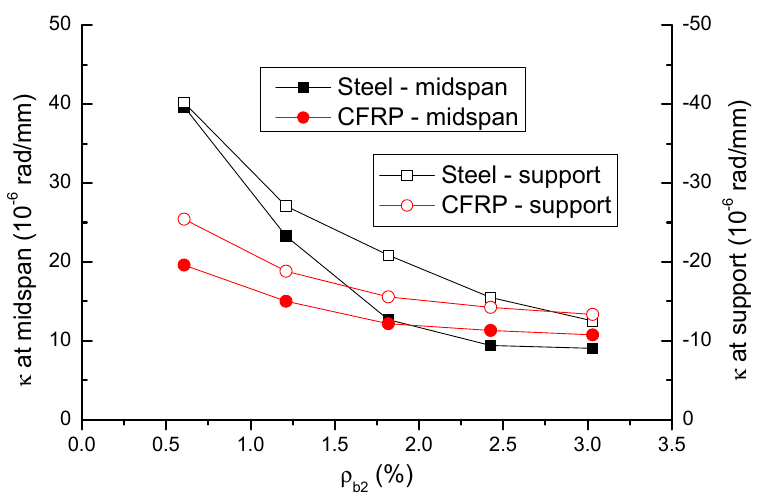
Figure 5. Moment–curvature curves.